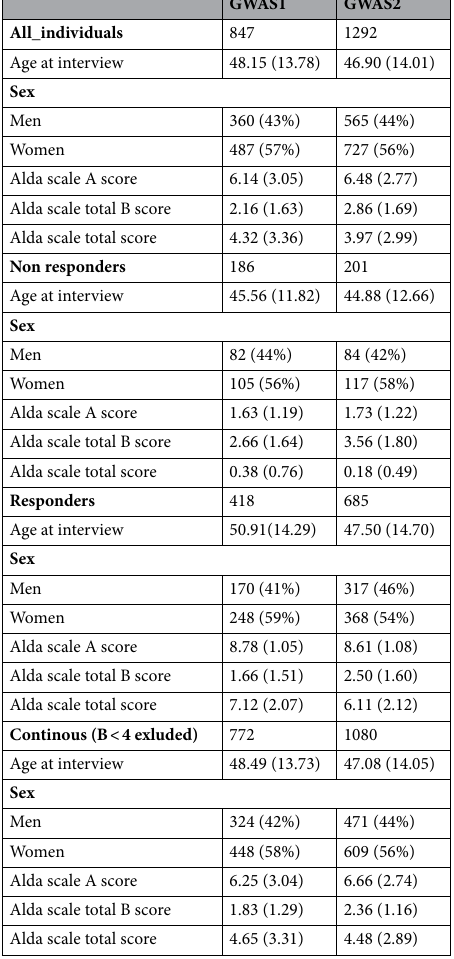
HLA protein, position,